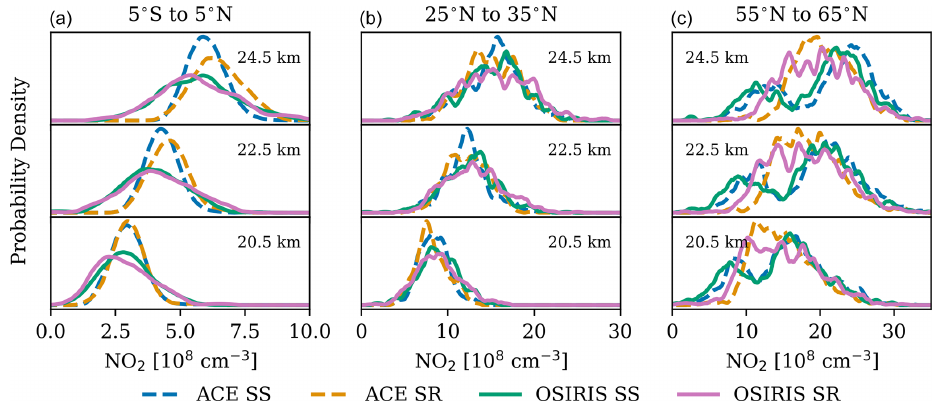
Figure 7. Probability densities for ACE-FTS v4.1 and OSIRIS v7.2 coincident NO 2 , after shifting from their individual local times to 12:00LST, for several altitudes from 5 ◦ S to 5 ◦ N (a) and from 55 to 65 ◦ N (c) .